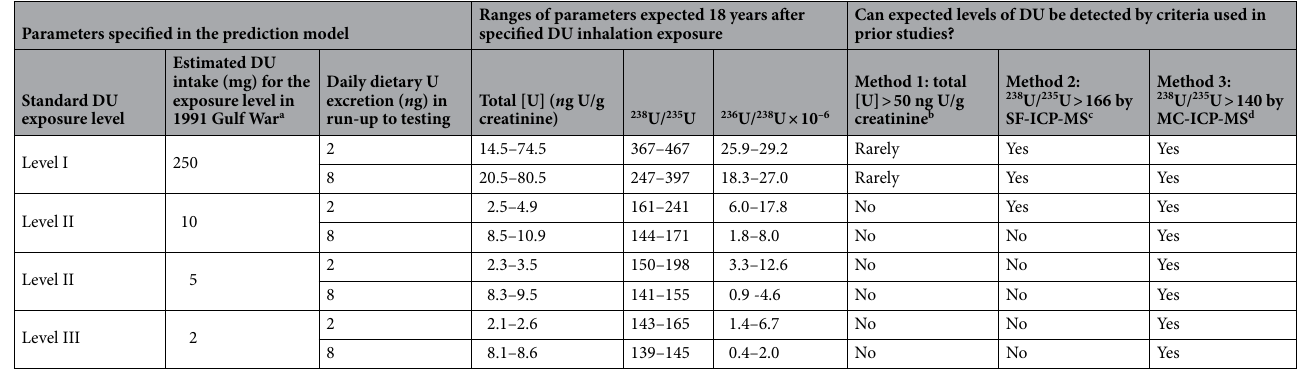
Table 1. Current ranges of urinary total [U] and U isotopic ratios that identify DU estimated from different levels of DU inhalation exposure during the 1991 Gulf War, time since exposure, and daily dietary intake of natural uranium running up to urine sample collection. a Numerical values are derived from calculations of 8,23,24 as illustrated in Fig. 1, described in more detail in on-line methods. b In the most recent study of DU in Gulf War veterans, Dorsey et al. 20 screened urine total [U] for DU by this criterion. c Dorsey et al. 20 identified the presence of DU with the 238 U/ 235 U ratio measured by lower precision sector field–inductively coupled plasma-mass spectrometry (SF-ICP-MS). d The present study identified the presence of DU with the 238 U/ 235 U ratio measured by the high precision multiple collector–inductively coupled plasma-mass spectrometry